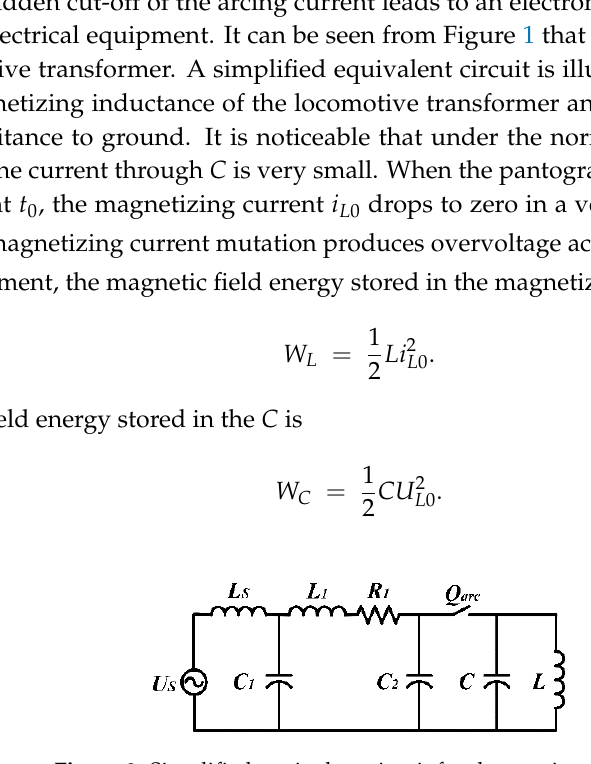
Figure 3. Transformer transient waveform when the pantograph arcing current extinguishes. 2.4. Simulation of the Overvoltage Phenomenon of Pantograph Arcing The simulation schematic circuit is implemented by Matlab Simulink as shown in Figure 1. Considering the operating conditions in practice for the CRH2 high speed railways, the parameters of the traction power supply system are adopted the same as in ref. [25], which is U s = 27.5 kV rms, L s = 31.8 mH, R 1 = 2.95 Ω , L 1 = 23.5mH, C 1 = C 2 = 0.081 μ F. The turns ratio of the locomotive transformer is set to be 25 kV:1.5 kV, the DC link voltage is 3 kV, the DC link filter capacitors are set to be 0.016 F. The time instant of the pantograph–catenary disconnection is set to be at 0.613 s. The simulation results of the pantograph arcing and transformer waveforms are shown in Figure 4. The whole system operates stably until the pantograph–catenary disconnection occurs at 0.613 s. The pantograph–catenary arcing occurs immediately and exists until 0.67 s. The arcing current drops to zero and is cut-off at 0.67 s. Notice that before the arcing current extinguishes, the value of the arcing current is equal to the sum of the magnetizing current and the load current reflected from the secondary side. In other words, although the arcing current drops to zero at 0.617 s, the magnetizing current is nonzero at this moment. The abrupt change of the circuit leads to resonance between the magnetizing inductance and stray capacitance, thus causing overvoltage across the transformer. As observed in Figure 4b, the maximum overvoltage can be about 6 kV. Hence, the extinguishment of the pantograph arcing can cause 1.7 times overvoltage across the transformer. The duration of the transient process is about two periods (0.04 s). But in the actual situation, since the pantograph– catenary detachment is frequent, the overvoltage can be a continuous potential problem for the safe operation of the locomotive equipment.